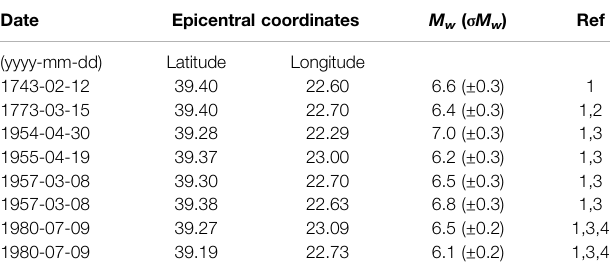
TABLE 1 | Focal parameters of the M w ≥ 6.0 strong earthquakes that occurred in the Southern Thessaly Fault Zone since 1700. Date Epicentral coordinates